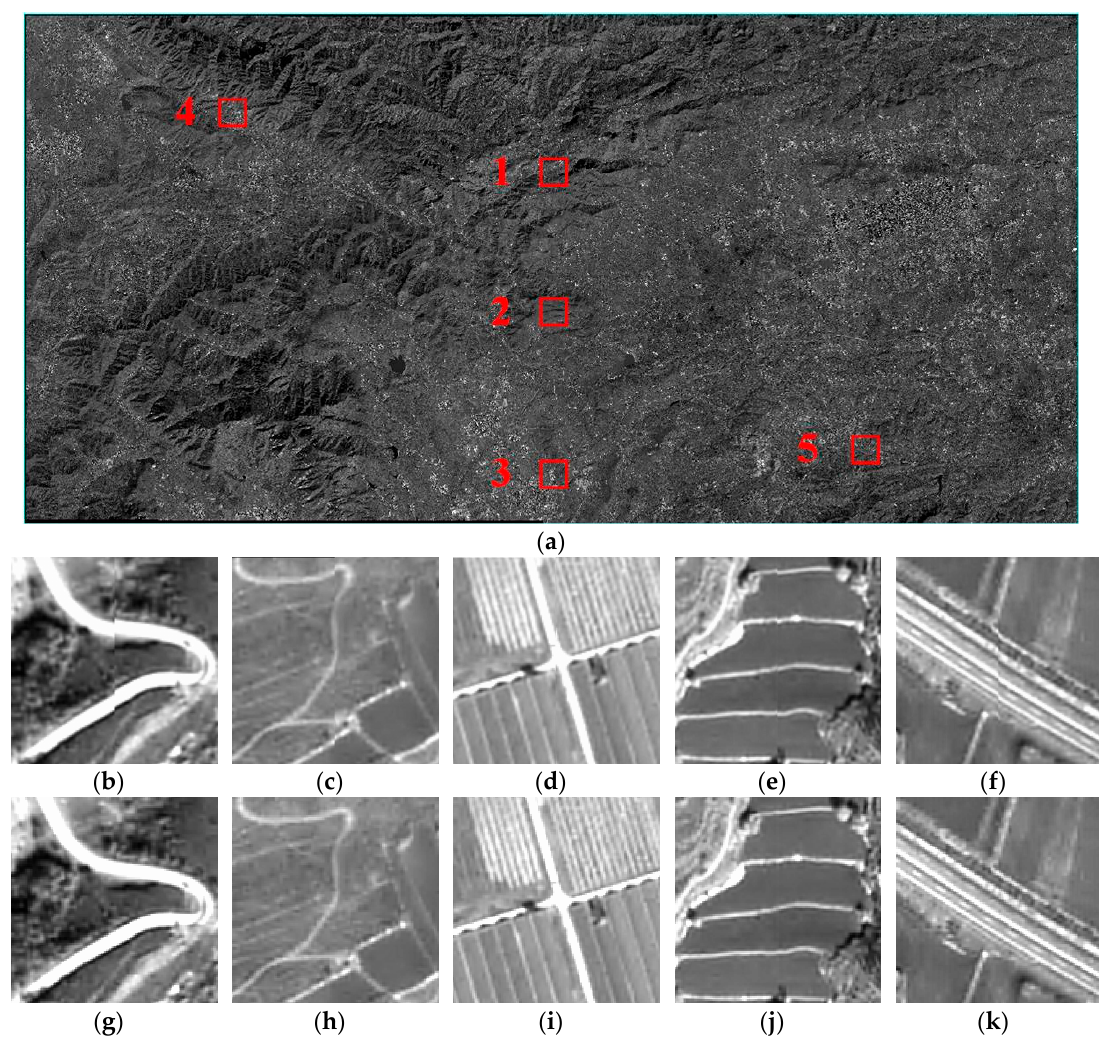
Figure 5. Experimental results of the GF2 satellite imagery: ( a ) The complete stitched image; ( b ) Original overlapping area 1; ( c ) Original overlapping area 2; ( d ) Original overlapping area 3; ( e ) Original overlapping area 4; ( f ) Original overlapping area 5; ( g ) Updated overlapping area 1; ( h ) Updated overlapping area 2; ( i ) Updated overlapping area 3; ( j ) Updated overlapping area 4; (k) Updated overlapping area 5.